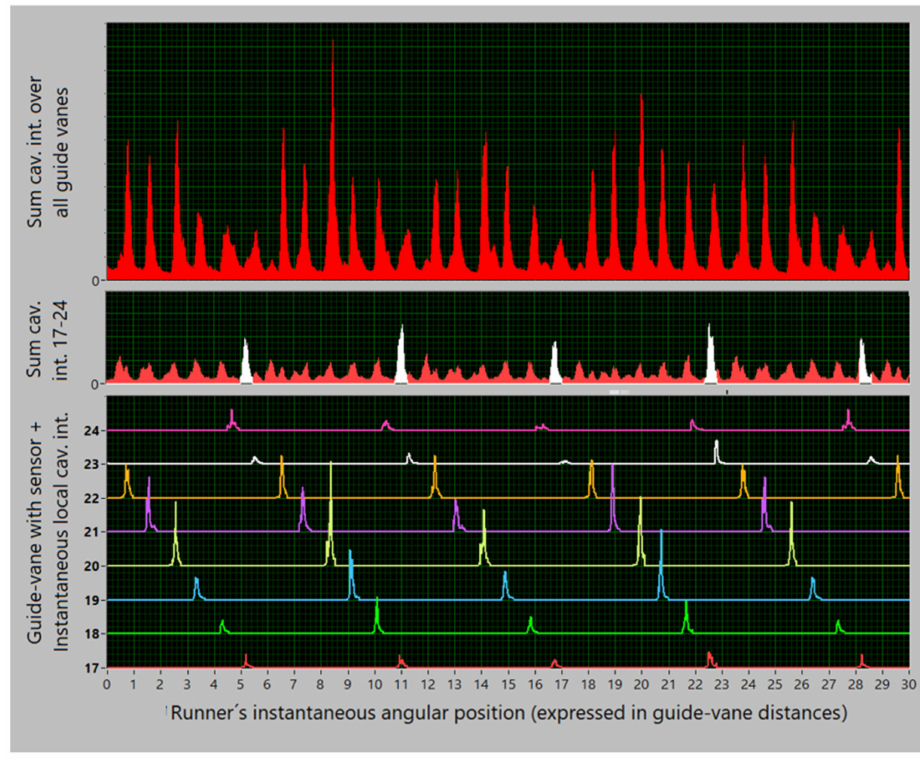
Figure A5. All as in Figure A4, with the extracted rotating mechanism turned back in the big graph into the format of Figure A1, thus with I (